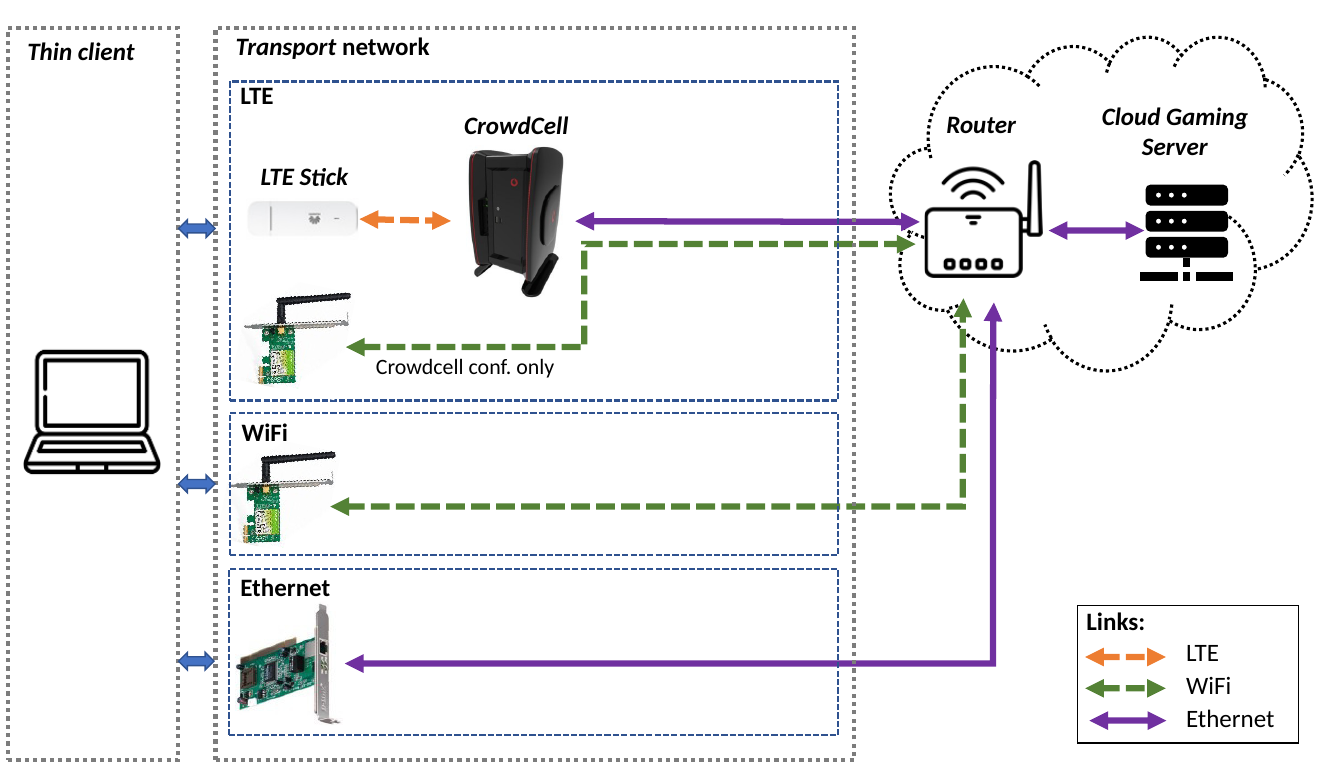
Figure 5. Testbed